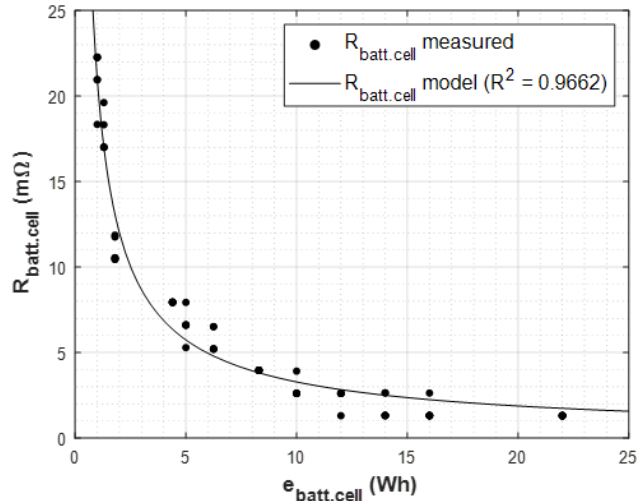
Figure 13. Internal resistance of the Single cell LiPo battery samples according to the